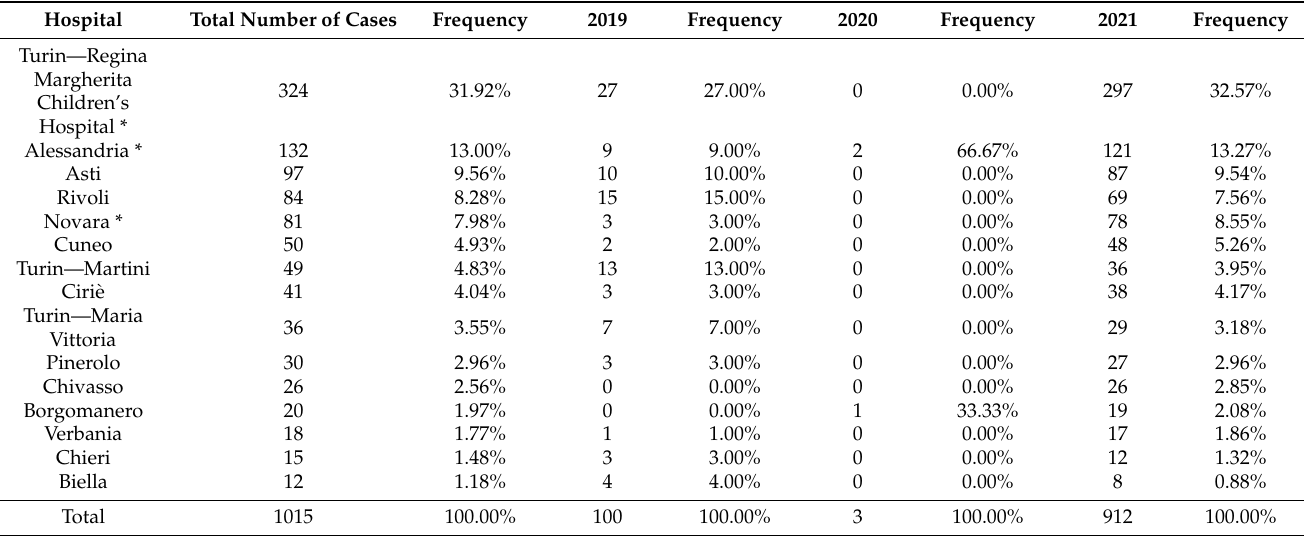
Table 1. Hospital admissions (total number and percentage) for each participating center during the study period.